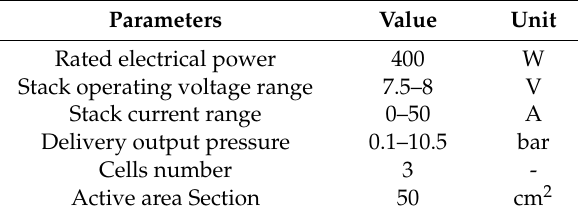
Table 1. Main features of the investigated PEM EL.